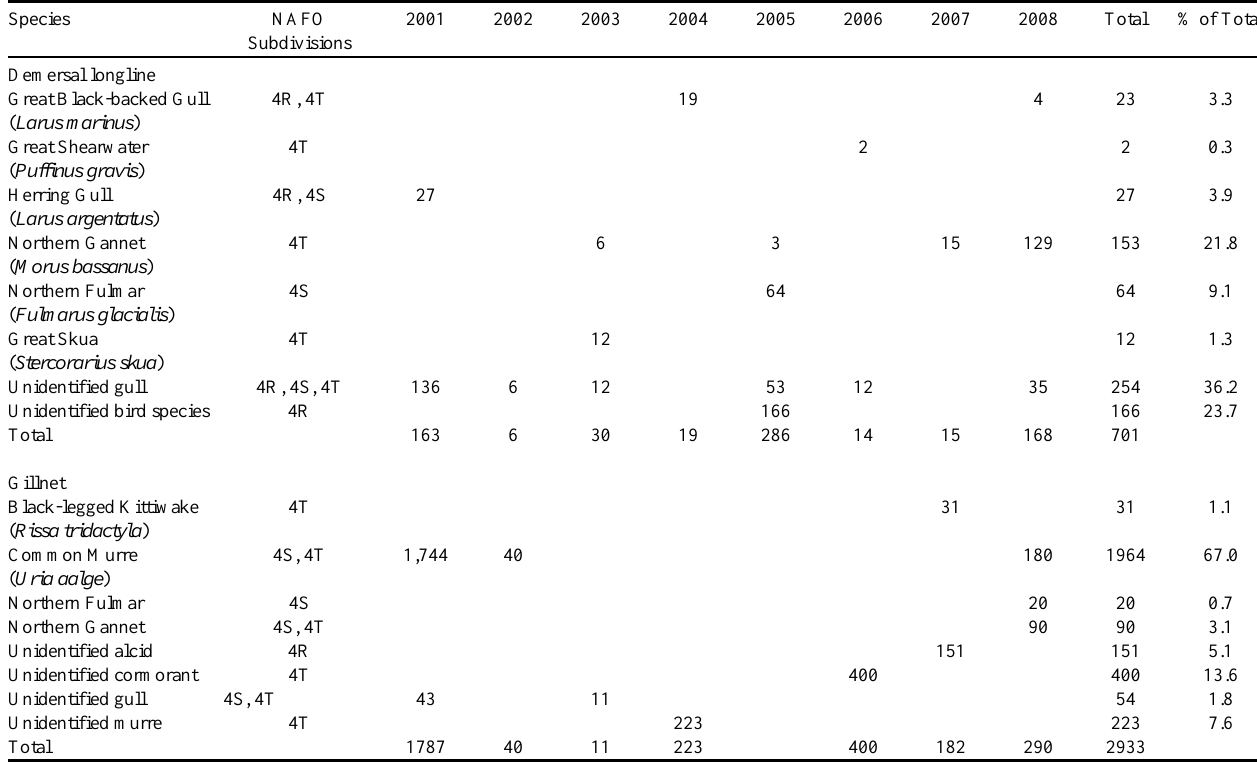
Table 2 . Extrapolated estimates of birds incidentally caught in demersal longline and gillnet fisheries, based on data collected through the Gulf Fisheries Observer Program (2001-2008) and total landings data provided by Department of Fisheries and Oceans. NAFO = Northwest Atlantic Fisheries Organization.